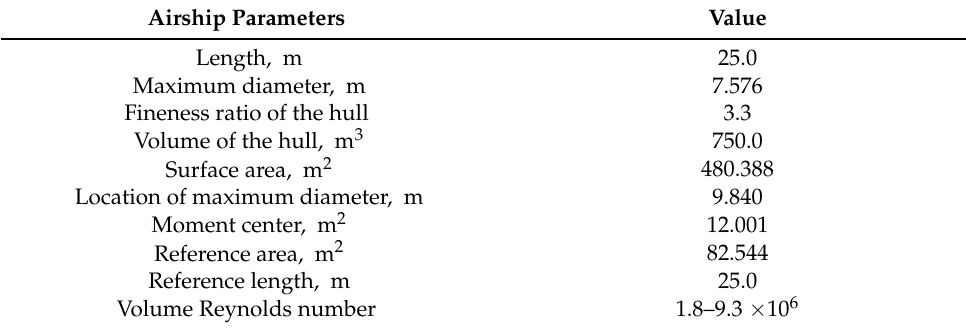
Table 1. Airship model parameters.